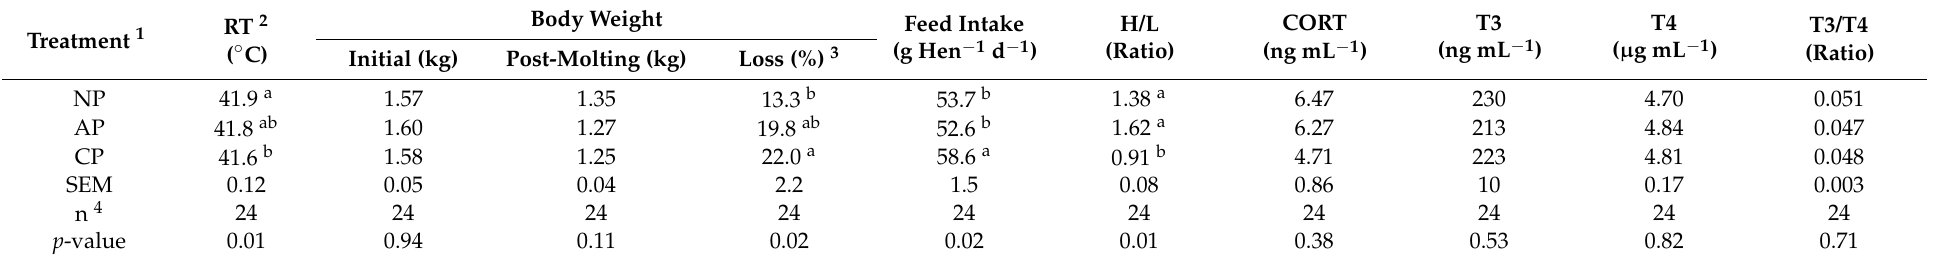
Table 4. The effects of cooled perches on rectal temperature (RT), body weight, feed intake, stress indicators (H/L, CORT), and thyroid hormones in caged laying hens during induced molt combined with daily cyclic heat or immediately post-induced molt.